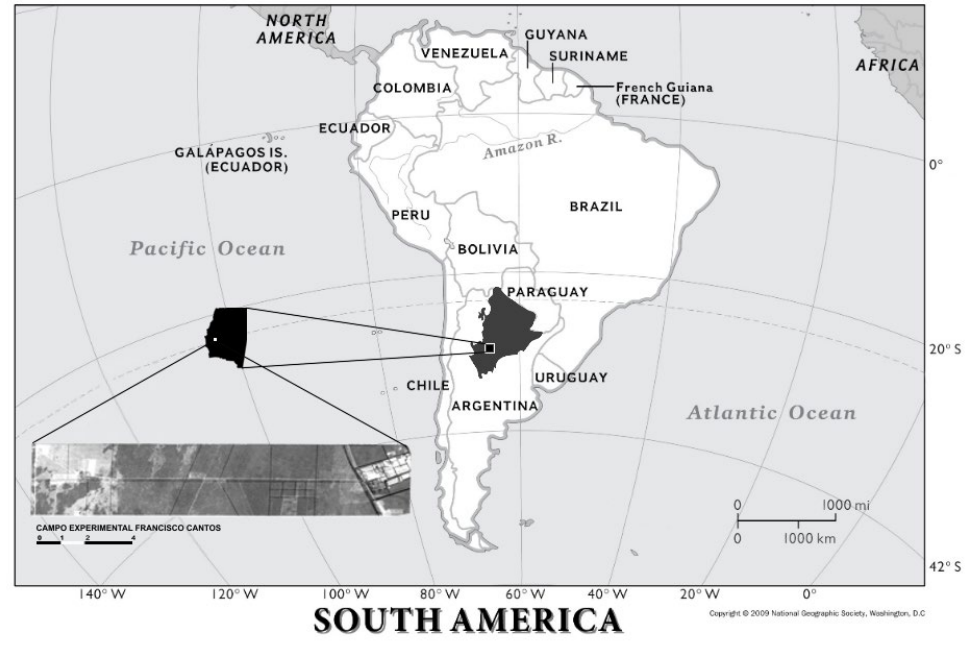
Figure 1. Localization of study area in the western Argentine Chaco region with the satellite image of the Experimental Ranch Francisco Cantos, Instituto Nacional de Tecnología Agropecuaria, Santiago del Estero (INTA).